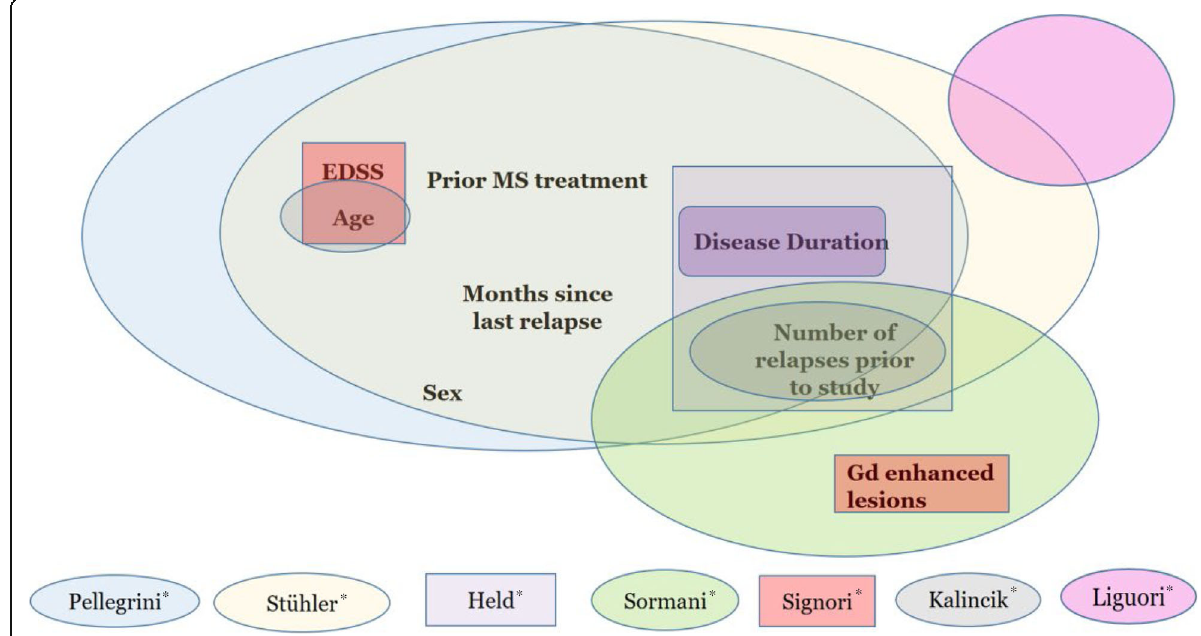
Fig. 1 Venn diagram of the prognostic factors included at least two times in pre-existing models and included in our prognostic model. The names with an asterisk refer to the first author of each prognostic model or prognostic factor research [ 7, 9, 10, 33, 34, 35, 36]. . EDSS, Expanded Disability Status Scale; Gd,